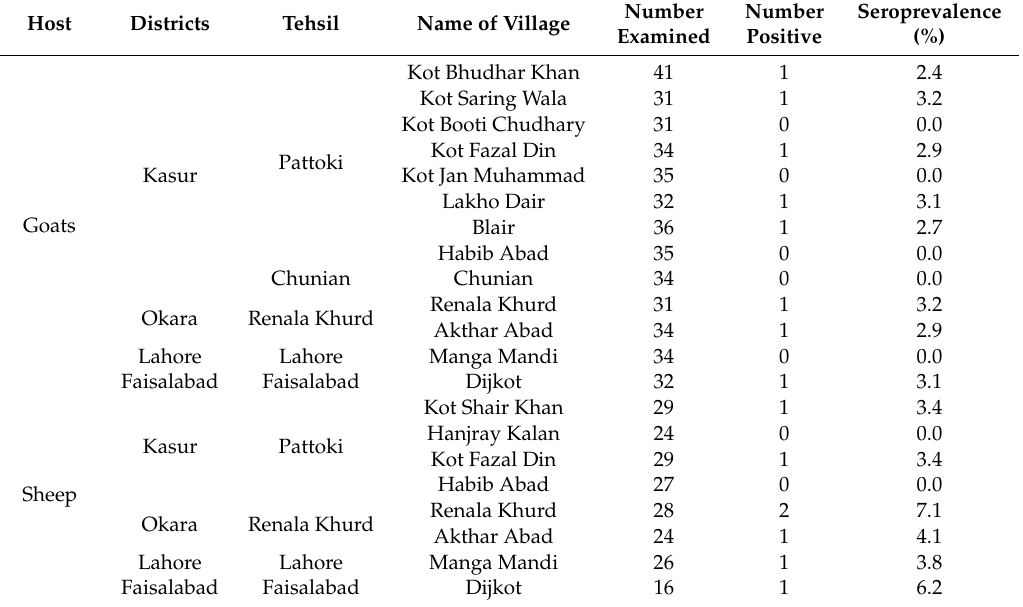
Table 4. The e ff ect of host and village in di ff erent districts on the prevalence of brucellosis in Punjab,